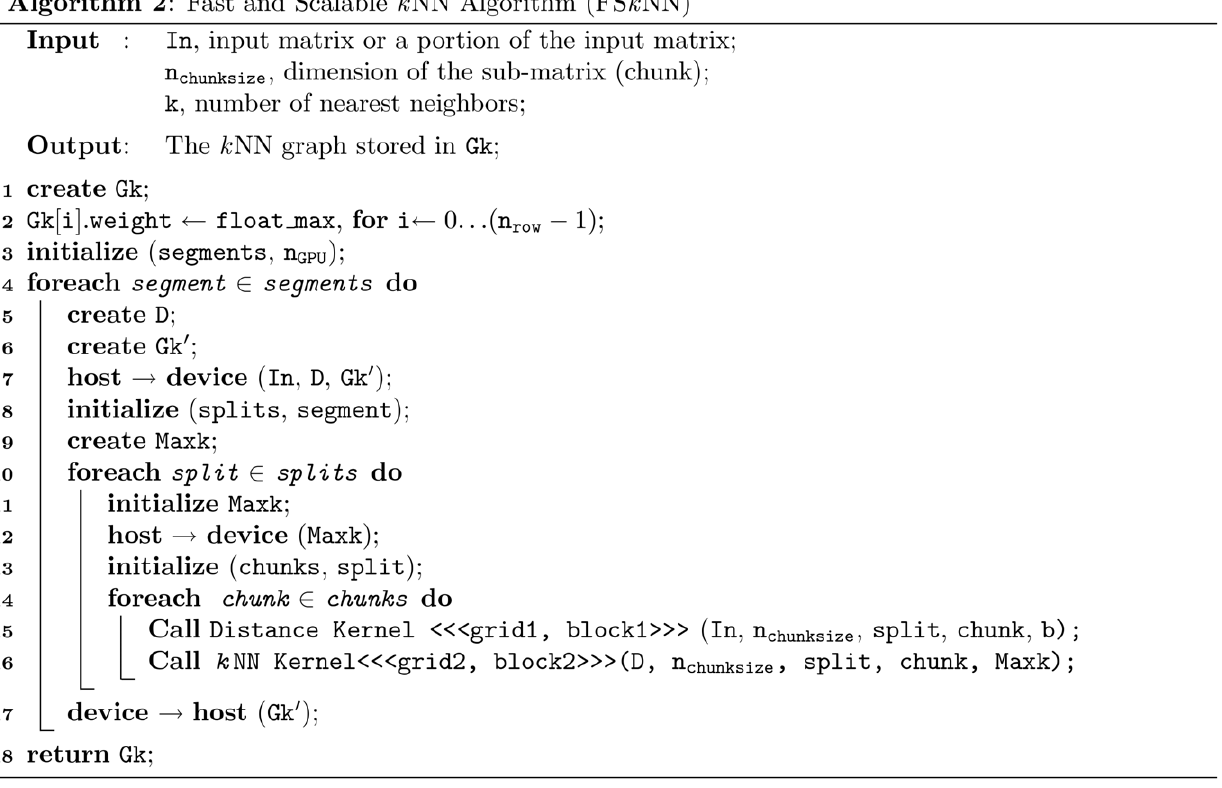
Figure 6. Pseudocode for the proposed scalable k NN search algorithm on GPU. The algorithm receives an input matrix (or a chunk of input matrix) In and produces a k NN graph ( Gk). It divides the complete distance matrix into small sub-matrices (‘‘chunks’’) and after computing all the chunks in a split, a partial k NN graph is derived which eventually becomes the final k NN graph, when all the chunks in each split and all the splits in each segment are computed. The method has two level of parallelism, chunk level and segment level . The segment level parallelism is only applicable when the system has more than one GPU.